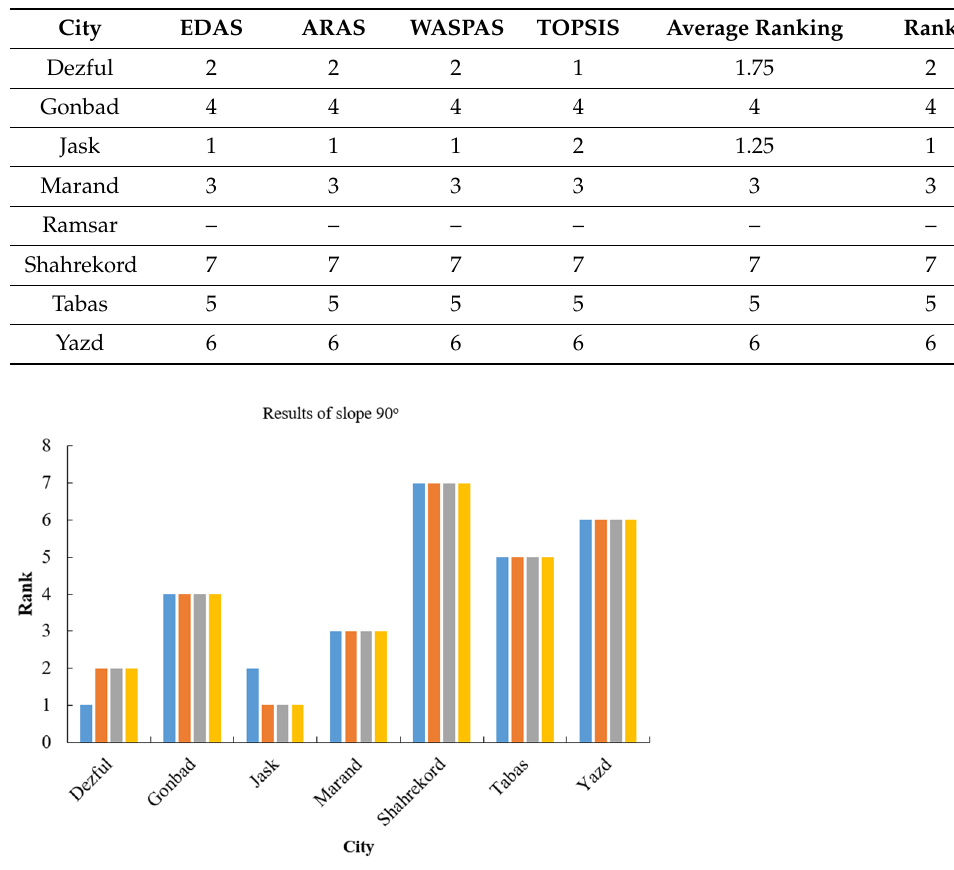
Table 17. Final ranking of cities on a 90 ◦ slope.